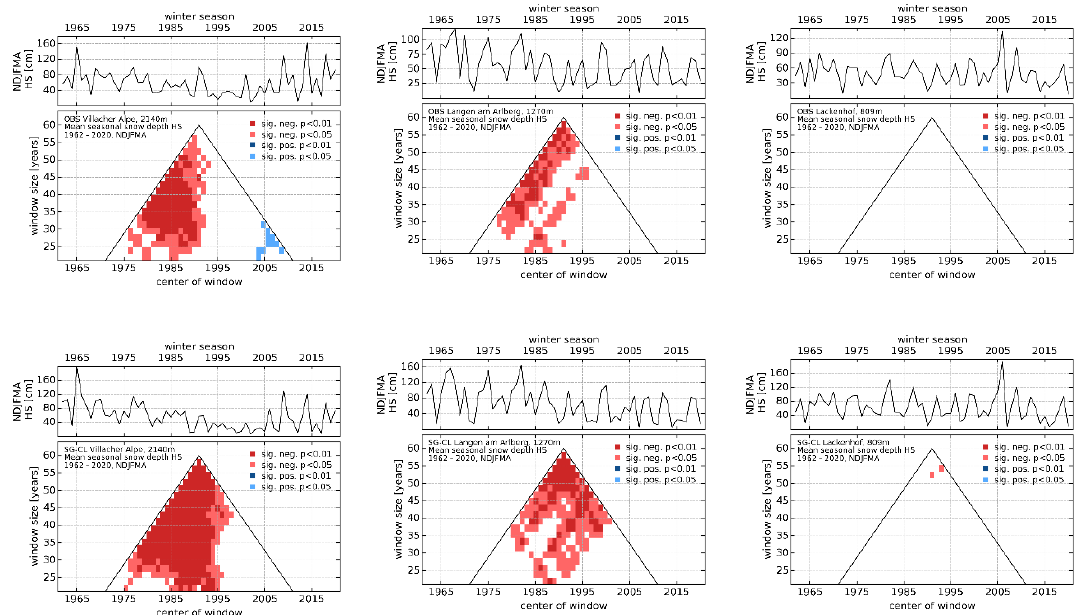
Figure 5. Observed ( top panels ) versus modelled (SG-CL, lower panels ) trend of snow depth. Mann–Kendall running-trend of seasonal HS (NDJFMA) for three stations for the period 1961/62–2019/20. The stations are (from left to right): Villacher Alpe (2140 m), Langen am Arlberg (1270 m), Lackenhof (809 m).